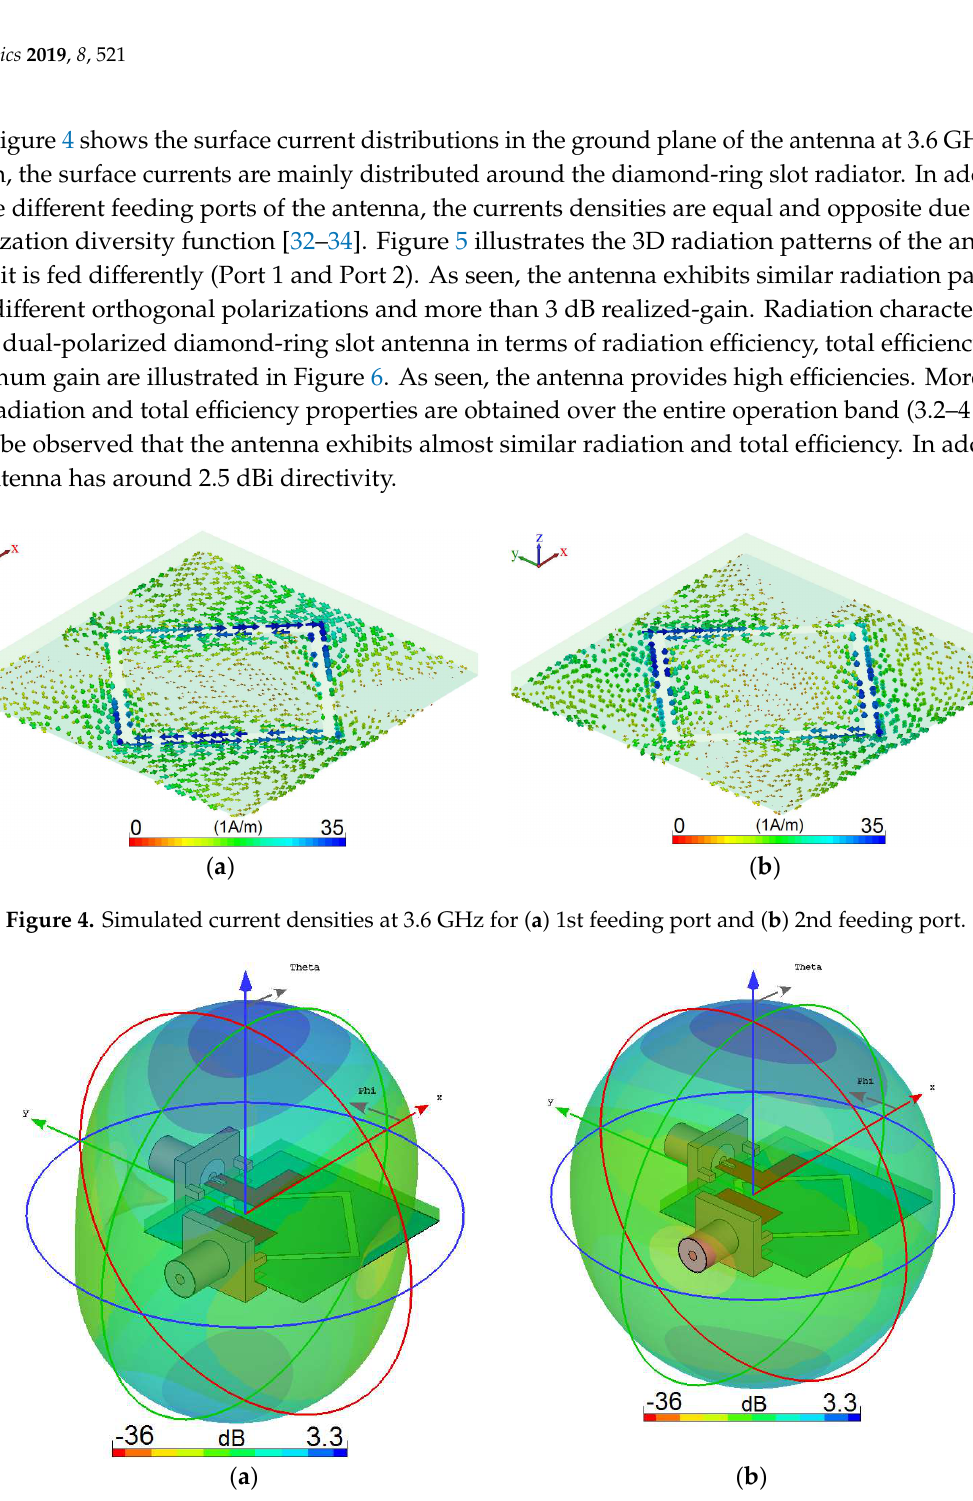
Figure 6. Radiation, total efficiencies, maximum gain of the diamond-ring slot antenna.